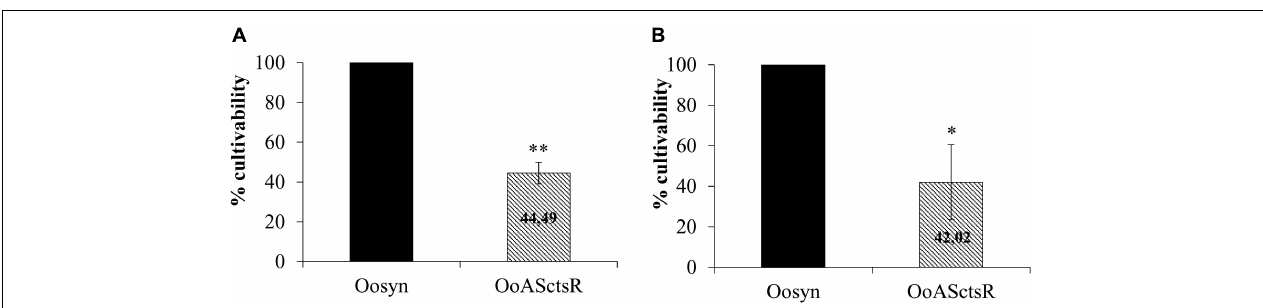
FIGURE 2 | Cell cultivability following stress treatment. Recombinant strains carrying the control empty vector (Oosyn; black bars) or plasmid with asRNA targeting ctsR (OoASctsR; hatched bars) were grown at 28 ◦ C until mid-exponential phase. Cultures were transferred to 48 ◦ C (A) or into acidified FT80m medium (pH 3.5) (B) . Cultivability was estimated on agar plates (CFU · ml - 1 ) after 90 min treatment. After CFU counting on agar plates, the cultivability rate is calculated by dividing the number of cells following treatment by total number of cells before stress treatment, normalized to the reference strain Oosyn set at 100%. Significant differences are based on a unilateral and paired t -test ( ∗∗ P < 0.005; ∗ P < 0.05).